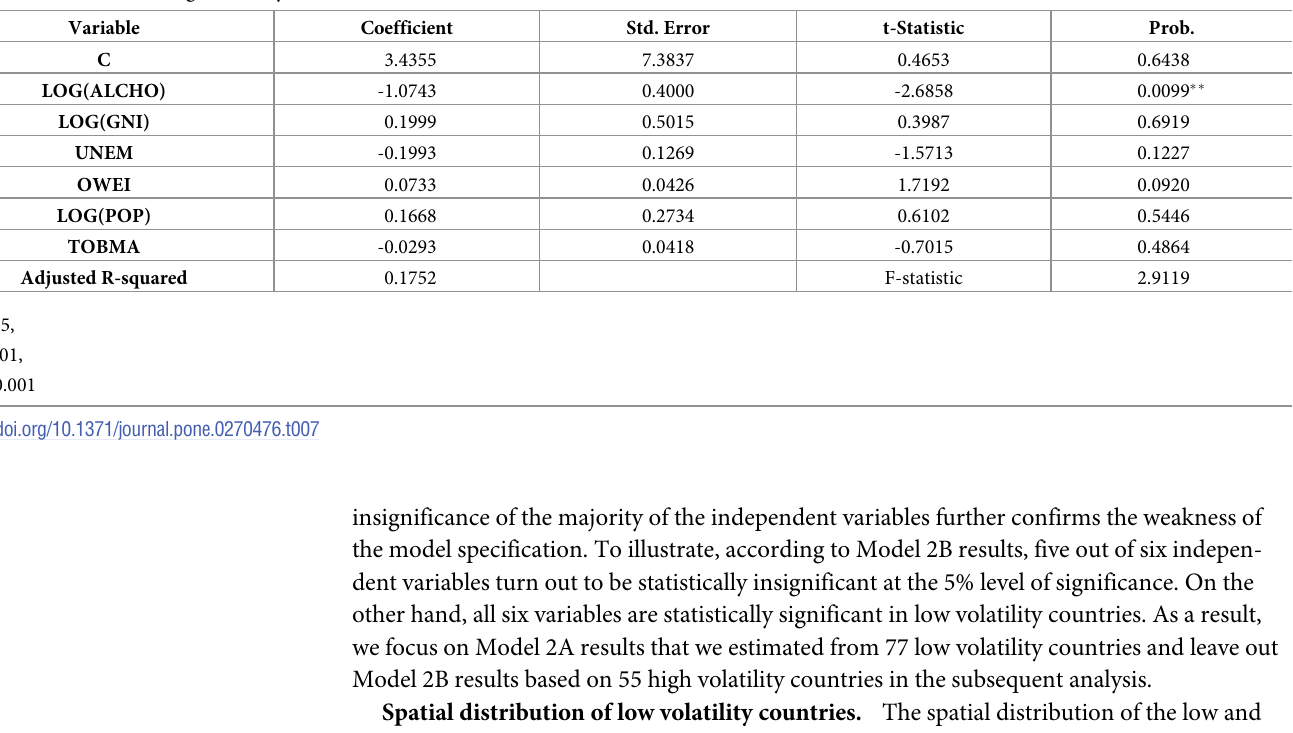
Table 7. Model 2B results: High volatility countries.